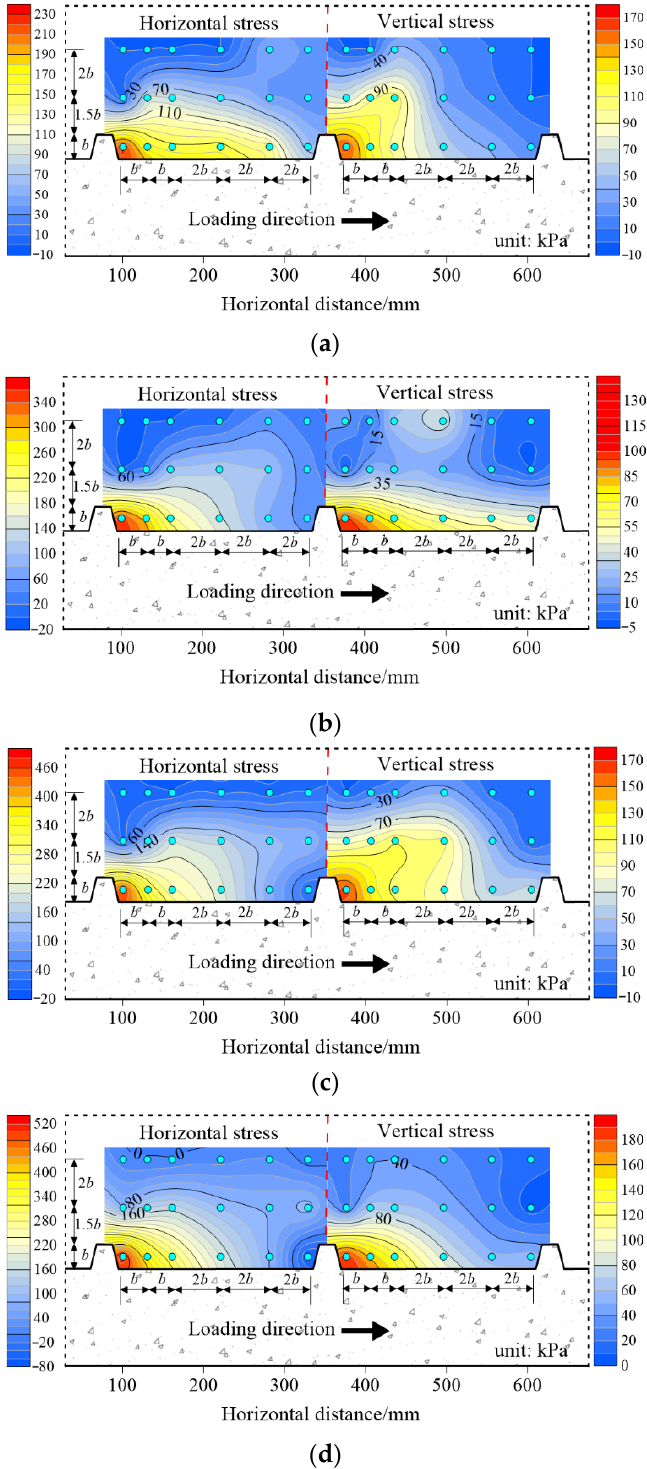
Figure 12. Final soil stress distribution of the 8 b screw shear plate. ( a ) 40 kPa, ( b ) 80 kPa, ( c ) 120 kPa, and ( d ) 160 kPa.